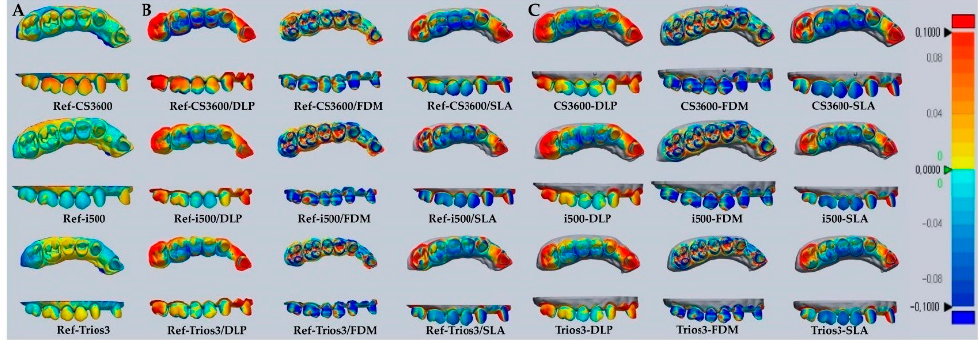
Figure 3. Representative deviations of superimposition using a surface matching software on the 3D digital model. Range of deviation was color coded from − 100 (blue) to + 100 µ m (red). ( A ) superimposition between Ref-IOS data. ( B ) superimposition between Ref-IOS / 3DP data. ( C ) superimposition between IOS-3DP data.